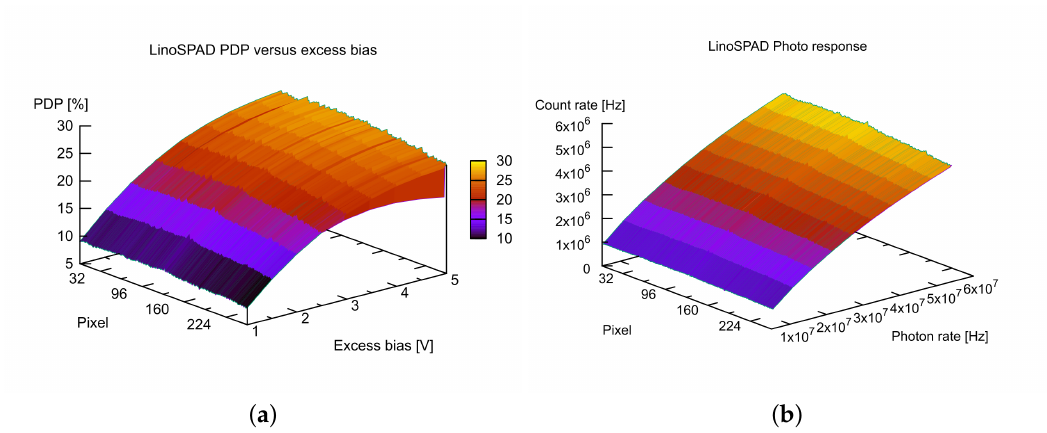
Figure 7. ( a ) PDP versus excess bias voltage; and ( b ) count rate versus photon rate (photo response). Both are recorded using a narrow spectrum LED at 465 nm. In ( a ), the illumination intensity is constant at 1 µ W/cm 2 for excess bias voltages from 0.5 V to 5 V; while, in ( b ), the excess bias is constant at 2 V for illumination intensity levels between 1 µ W/cm 2 to 10 µ W/cm 2 . Count compression occurs for the highest excess bias voltages and photon rates, where pixels reach saturation and the observed count rate decreases.